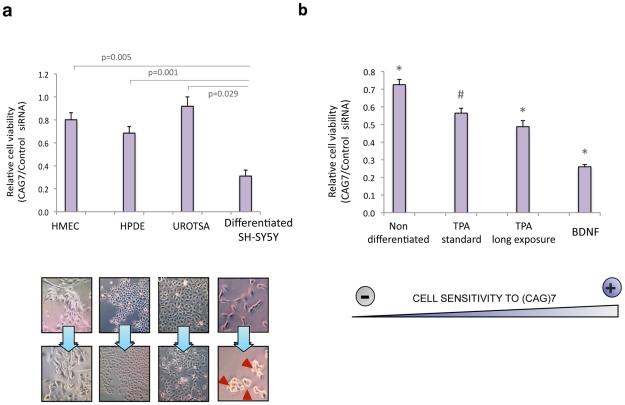
sCAG toxicity is variable in different human cells, preferentially affecting neuronal viability.A. Exogenous administration of (CAG)7 siRNAs interfere with cell viability depending on the cell type (n = 3, p<0.0083). HMEC, HPDE and UROTSA cell lines were used as a source for breast, pancreatic and bladder primary human cells. Differentiated SH-SY5Y cells were used as a post-mitotic neuronal cell model (n = 3; one-way ANOVA *p<0.05 ***p<0.001; F = 15.203). B. The toxic effect of (CAG)7 siRNA is dependent on the type of differentiation. SHSY5Y cells were subjected to several neuronal differentiation protocols, and CAG)7 or scrambled sequences (control siRNA) were administered in each situation. SH-SY5Y sensitivity to (CAG)7 significantly differs in each differentiation condition (*), excepting for TPA standard differentiation condition (#), whose effect wasn't significantly different from the effect observed under TPA long exposure conditions (One-way ANOVA; F = 63.926). (n = 3, p<0.0083). MTT assays were performed 48 hours after transfection. Graphs show relative cell survival indicated as the ratio between cell viability in cells transfected with controls siRNA vs cell viability in cells transfected with (CAG)7. Values indicate the mean ratio ± SEM of three independent experiments.